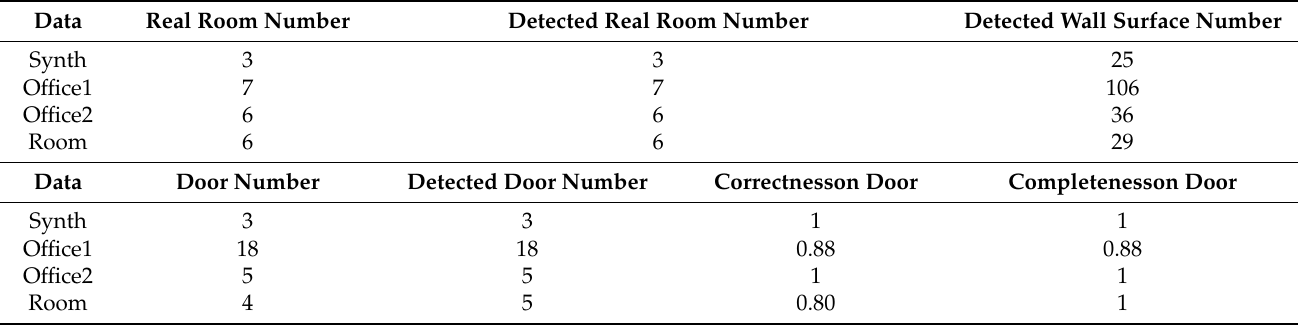
Table 6. Experimental results of some experiments without real ground data.